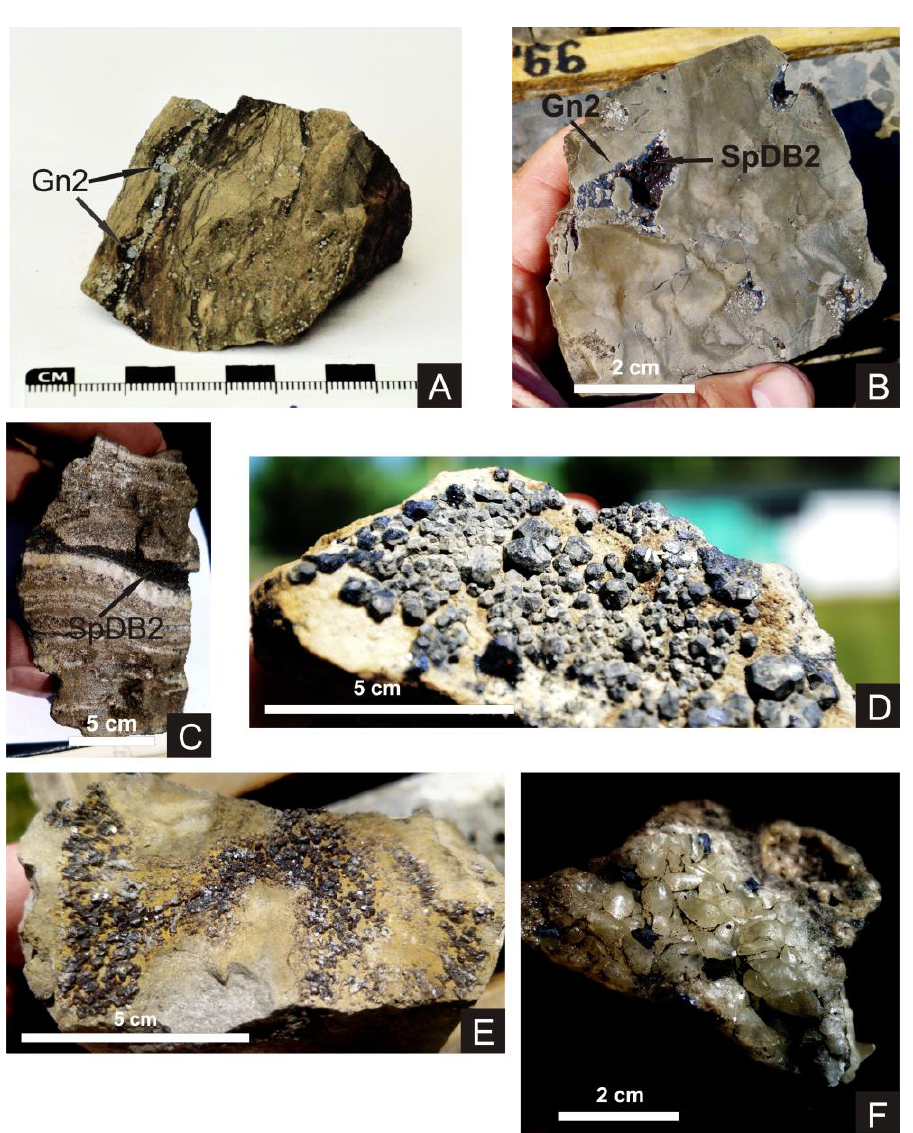
Figure 13. ( A ) Galena (Gn2) crystals within irregularly streaked dolomite, Zawiercie 93 TN borehole; ( B ) dolomite with visible unstable density layering structures, with many caverns partly filled with sphalerite and galena, Zawiercie TN 87 borehole; ( C ) stratified Zn-Pb ore, ”zebra-type”, Poręba MZ 23 borehole; ( D ) well-formed galena, in form of octahedrons and cubes, Gołuchowice 21 G borehole; ( E ) sphalerite crystallized on the cracked dolomite surface, Gołuchowice 2 G borehole; and ( F ) galena and white calcite forming the matrix of hydrothermal breccia, Kierszula TN 245 borehole.